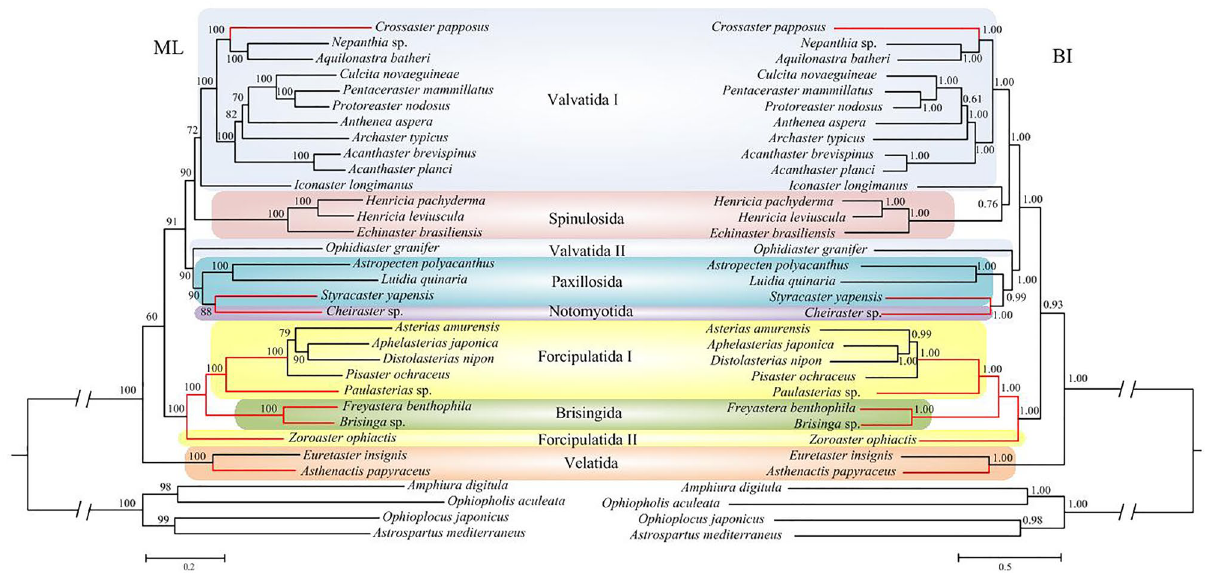
Figure 2. Phylogenetic analysis of ML and BI based on the nucleotide sequencces of the 13 concatenated protein-coding genes. The bootstrap probability and the Bayesian posterior probability were shown at each node. The deep-sea branchs were marked by red.